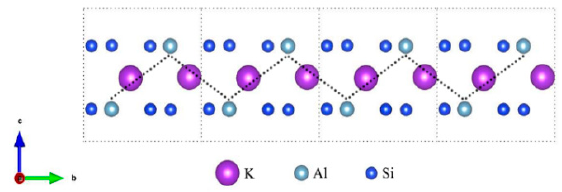
Figure 4. One layer of the muscovite model along the a -axis.